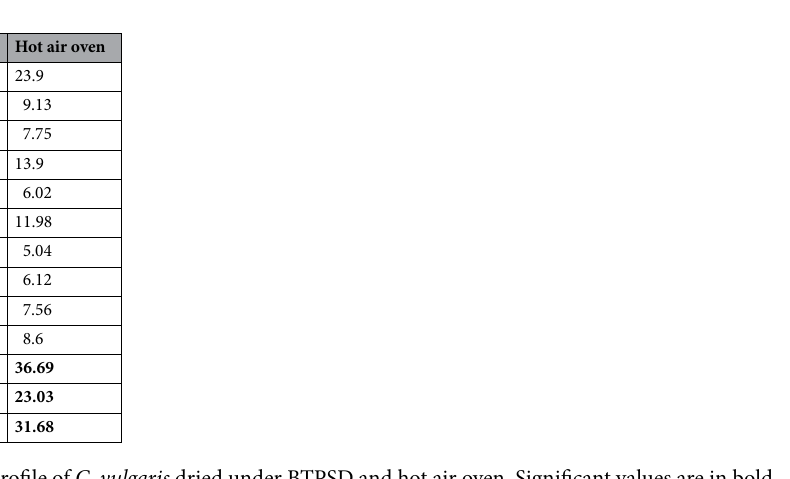
Table 2. Fatty acid profile of C. vulgaris dried under BTPSD and hot air oven. Significant values are in bold.